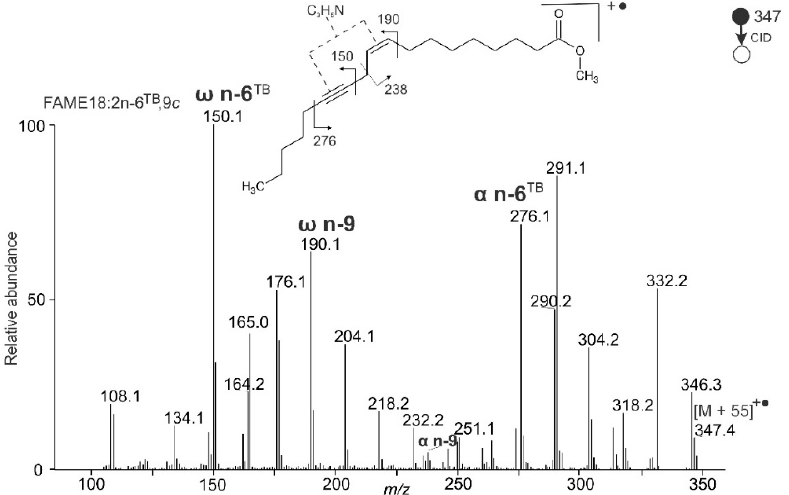
Figure 4. APCI MS/MS CID spectrum of the [M + 55] +• adduct of crepenynic acid methyl ester (FAME 18:2n-6 TB ,9c); MBR = 276 + 190 − 347 = 119.